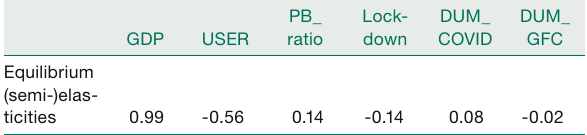
Table 2 reports the main estimation results. Variant V1